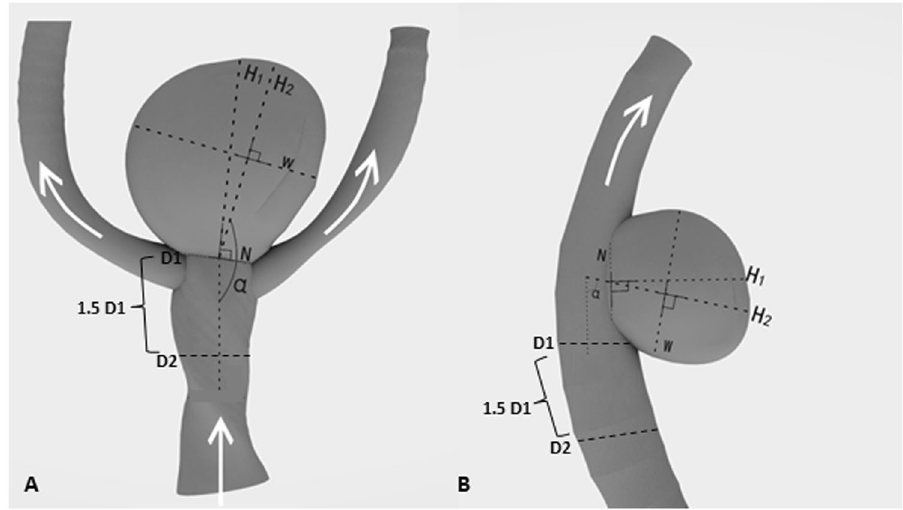
Figure 1. Definition of the morphological parameters in end-wall aneurysm ( A ) and side-wall aneurysm ( B ). Aneurysm size is defined as the maximum distance of the dome from the aneurysm neck plane (W). Aspect ratio (AR) is defined as the maximum perpendicular height (H1) of the aneurysm divided by the average neck diameter of the aneurysm (N). D1: the diameter of the parent vessel at the edge of the neck, perpendicular to flow; D2: the diameter of the parent vessel perpendicular to flow, measured at 1.5D1 from D1; average diameter: (D1 + D2)/2; size ratio (SR) is defined as the maximum aneurysm height (H2) divided by the average diameter. Height–width (H/W) ratio is defined as the ratio of H2/W. Aneurysm width–parent artery diameter ratio is the ratio between W/D1. Flow angle (FA) is defined as the angle between the maximum height of the aneurysm and the parent vessel ( α ).